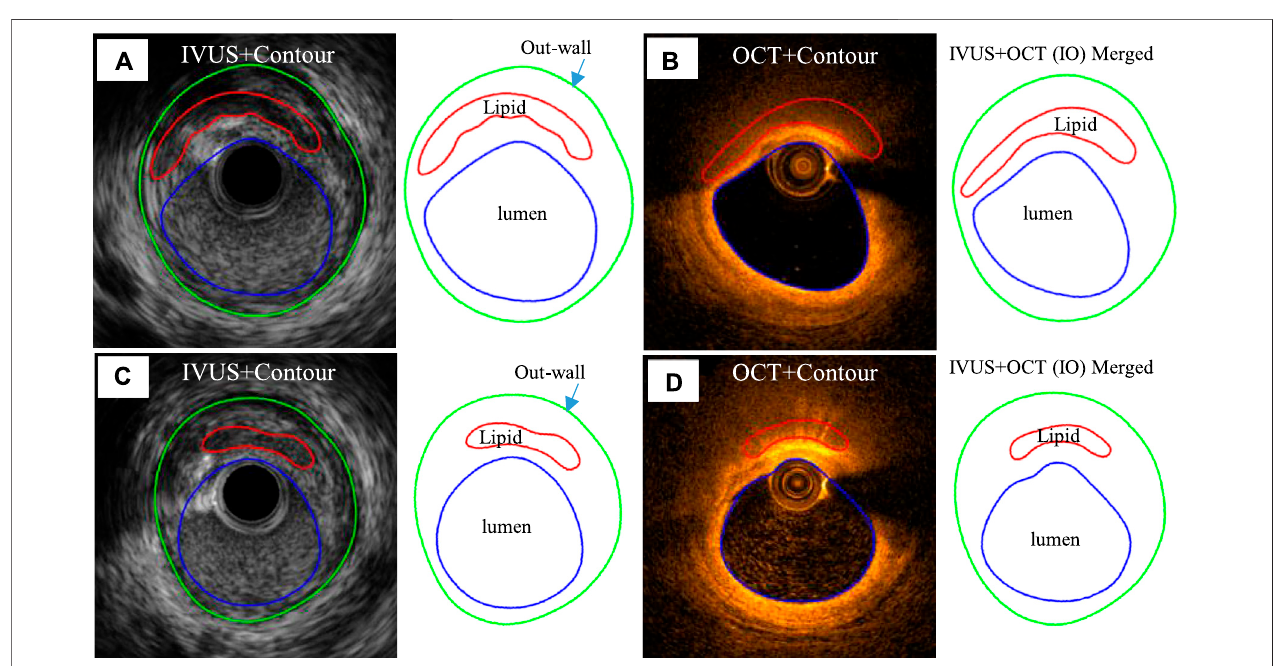
FIGURE 1 | Sample IVUS and merged IVUS + OCT (IO) slices showing segmentation and merging at baseline and follow-up. (A) IVUS slice and its segmented contours at baseline. (B) CorrespondingOCT slice and IVUS+ OCT(IO) slice at baseline. (C) IVUSslice and its segmented contour plot at follow-up. (D) Corresponding OCT slice and IVUS + OCT (IO) contour plot at follow-up. Outwall contours of IO slices are taken from IVUS.